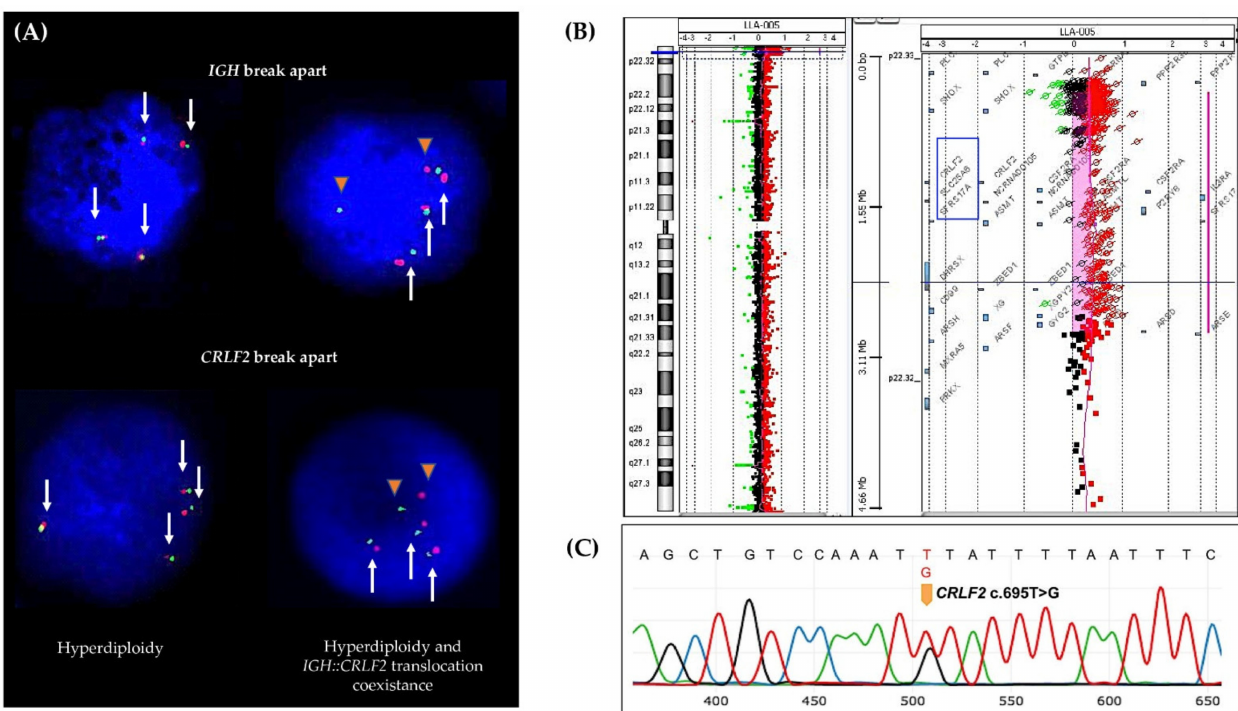
Figure 2. CRLF2 genetic lesions. ( A ) FISH assay showing cell clones with hyperdiploidy (left) and cell clones with IGH::CRLF2 translocation and hyperdiploidy coexistence (right). White arrows represent the IGH and CRLF2 loci and orange triangles represent the IGH::CRLF2 translocation (fused signals green/red represent IGH or CRLF2 normal loci, and separate green and red signals represent broken IGH or CRLF2 loci). ( B ) aCGH shows a copy number gain at Xp22.33 (ChrX: 403328-2865335) involving the CRLF2 gene. ( C ) Sanger sequencing shows the CRLF2 point mutation.